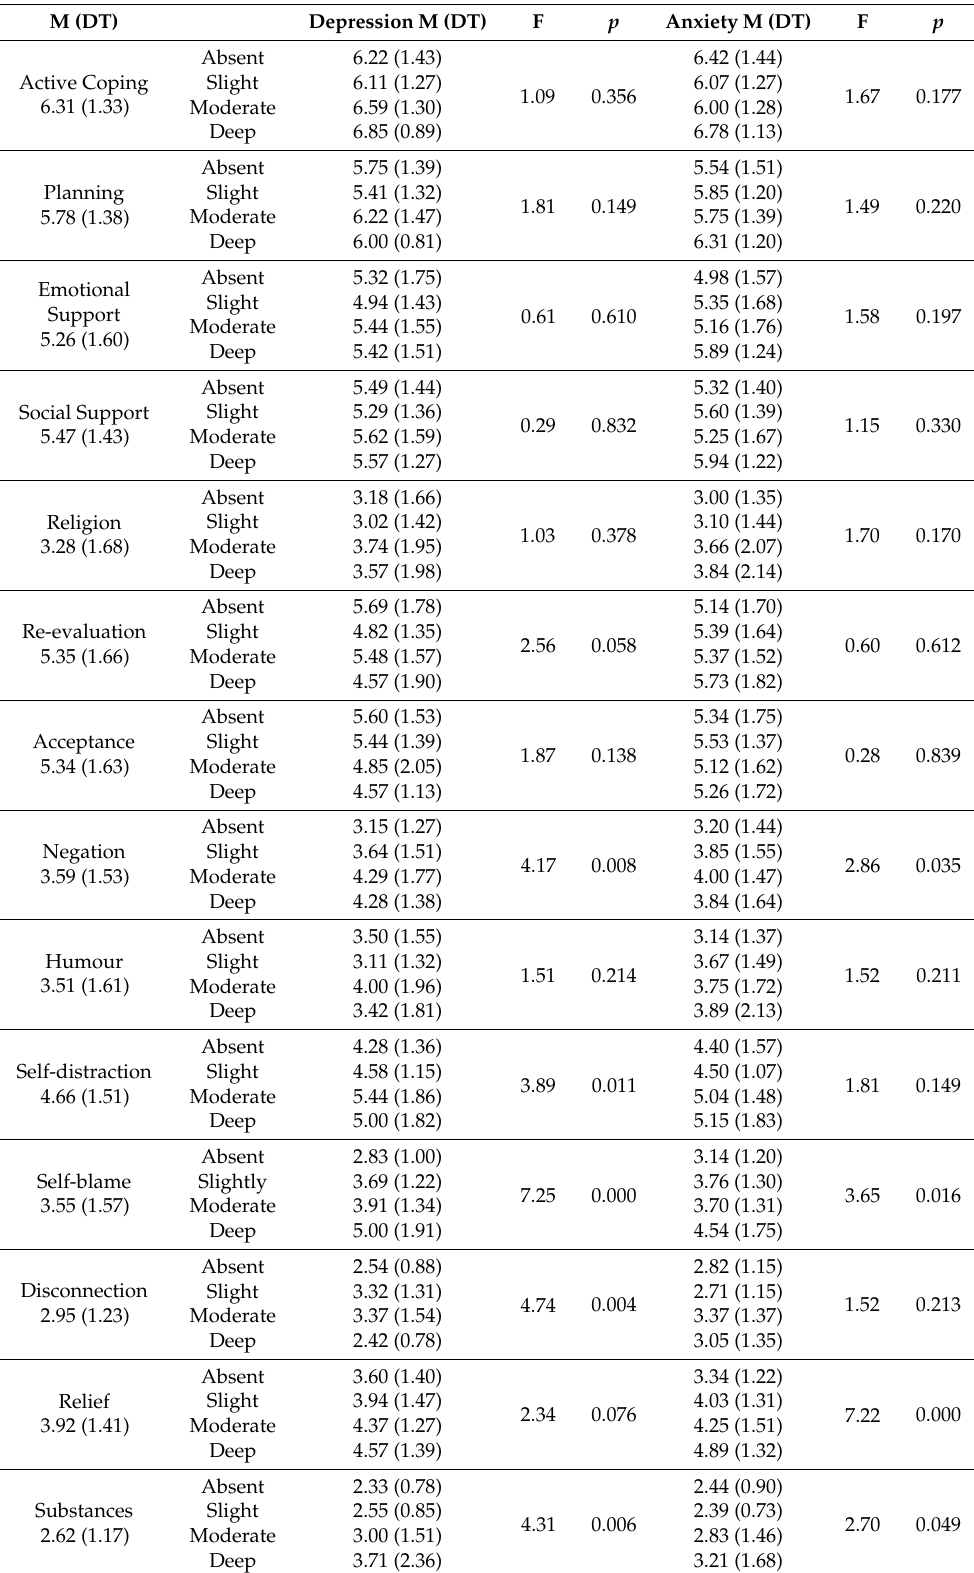
Table 3. Means, SD and ANOVA of COPE-28 for each anxiety and depression